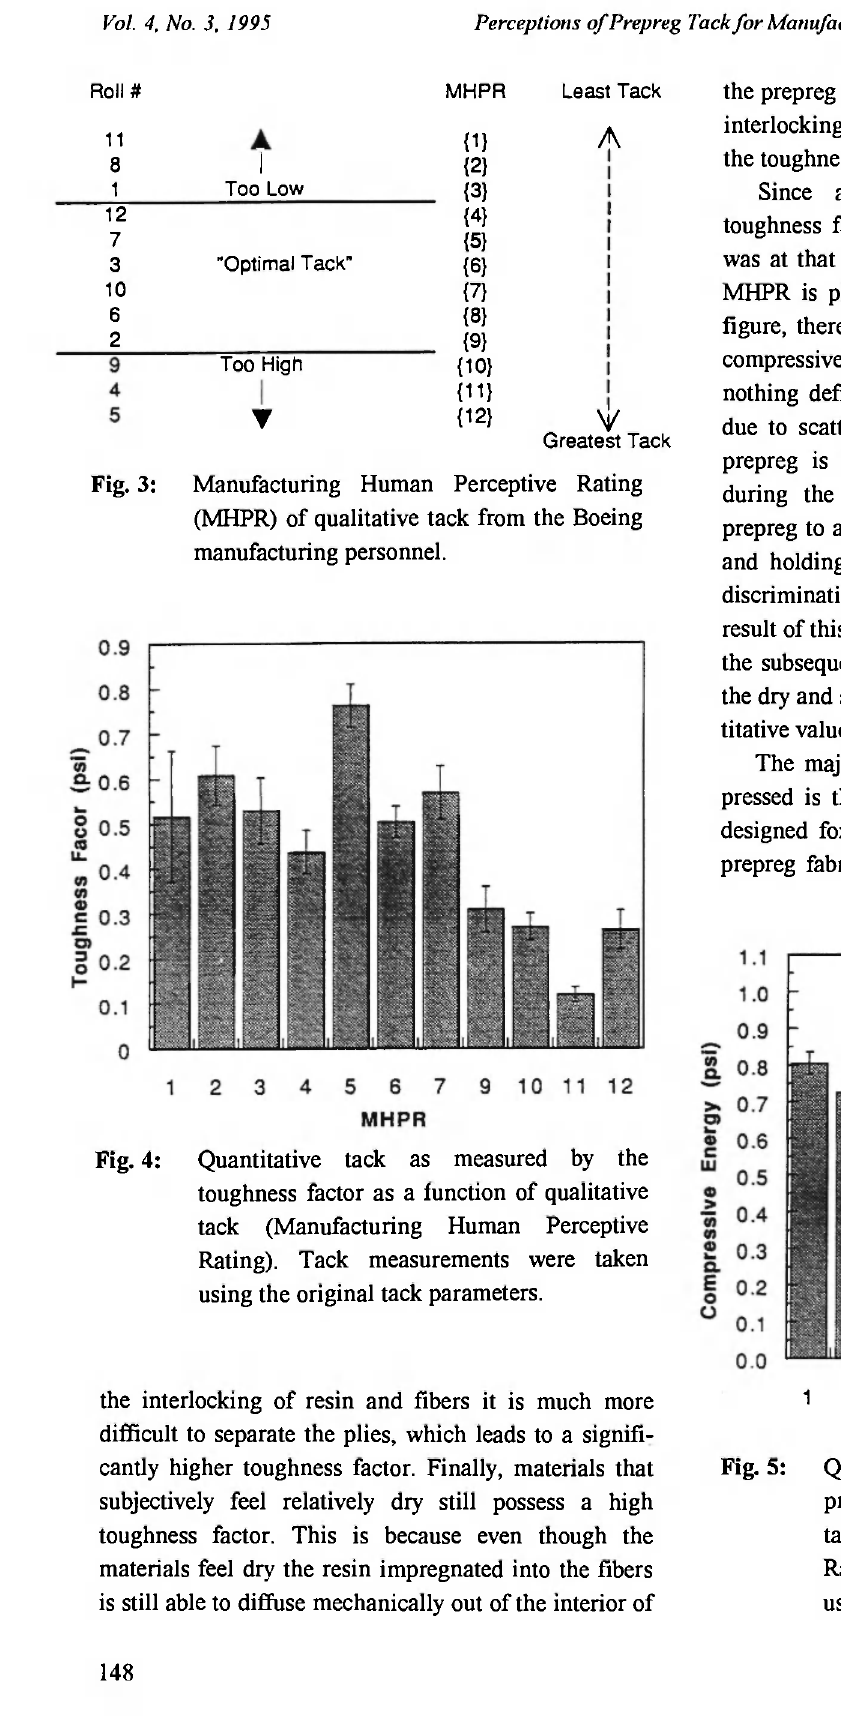
Quantitative tack as measured by the com- pressive energy as a function of qualitative tack (Manufacturing Human Perceptive Rating). Tack measurements were taken using the original tack